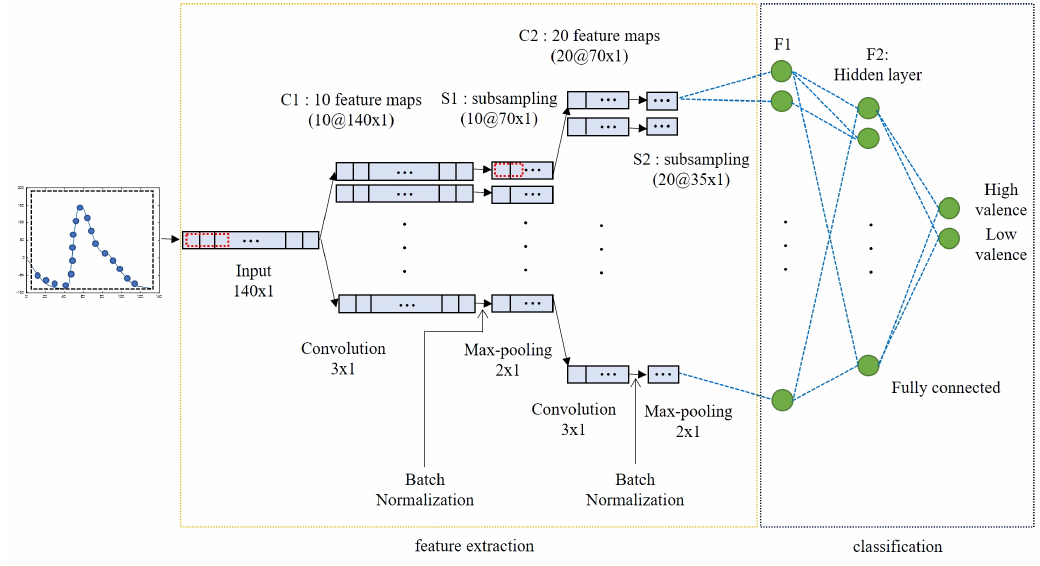
Figure 7. Proposed one-dimensional (1D) convolutional neural network (CNN) architecture for